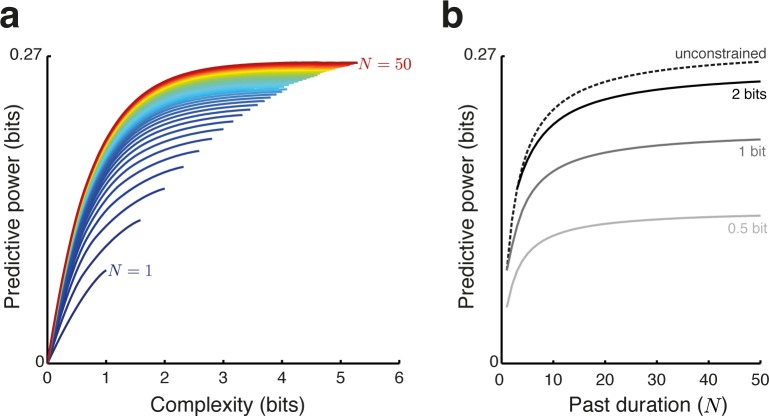
Tradeoff between complexity and predictive power in the oddball paradigm.(a) Tradeoff curves calculated for different durations of the past sequences, from N = 1 (blue) to N = 50 (red). The curves corresponding to N = 4 and N = 10 are the same as those shown in Fig 2. Each curve spans complexity values from 0 to that of the minimal sufficient statistic. While more complex representations exist, they cannot have higher predictive power. Each point along the curves represents one optimal solution (achieving maximal predictive power for its complexity constraint for the corresponding duration of the past). These curves separate achievable versus non-achievable combinations of complexity and predictive power (below versus above each curve, respectively). (b) The maximal predictive power that can be achieved as a function of the past duration N, for different constraints imposed on the complexity: 0.5 bit (light gray), 1 bits (dark gray), 2 bits (black). The dashed line corresponds to the predictive power of the minimal sufficient statistic, and is therefore the maximal predictive power at each past duration. Note the diminishing returns for increases in memory duration N (i.e. predictive power does not increase much beyond N = 10), as well as for increases in complexity (i.e. predictive power does not increase much beyond a complexity of 2 bits).